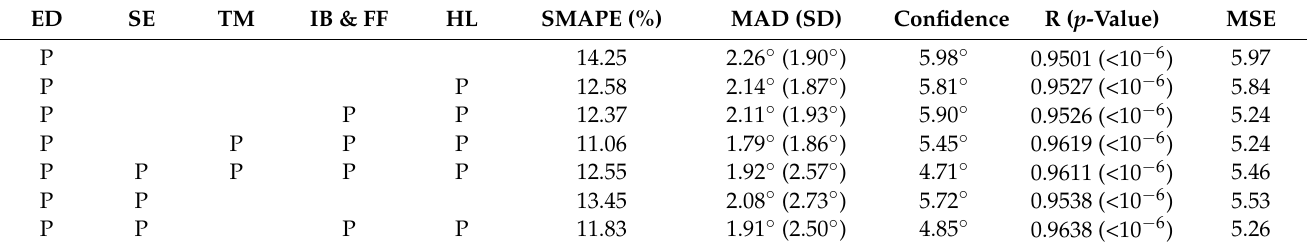
Table 1. Ablation studies of each component of our model. ED (encoder–decoder network); SE (SE attention); TM (transformer module); IB&FF (intermediate branch and feature fusion); HL (hybrid loss); SMAPE (symmetric mean absolute percentage error); MAD (mean absolute difference; SD (standard deviation); Confidence 95% (confidence interval of the difference of the statistic); R (Pearson correlation coefficient); MSE (mean square error). All ablation study experiments were conducted on the CS799 dataset.